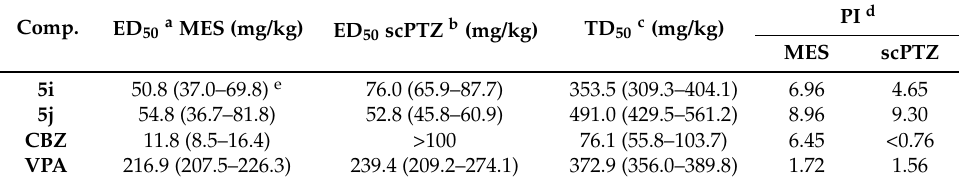
Table 4. Quantitative Pharmacological Parameters ED 50 , TD 50 , and PI Values in Mice.